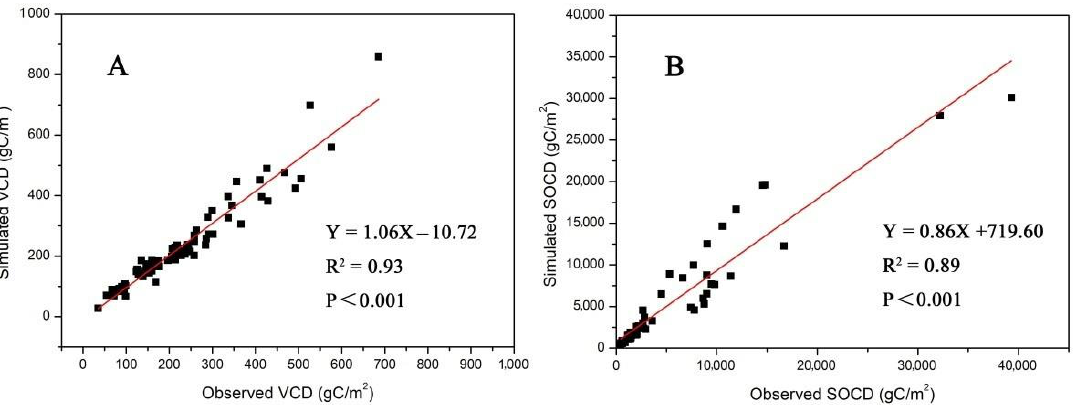
Figure 2. Comparison of vegetation carbon density (VCD) values based on simulated and obser- vational data ( A ) and soil organic carbon density (SOCD) values at different depths (including the upper 20 cm, upper 30 cm, upper 40 cm and upper 100 cm) ( B ).